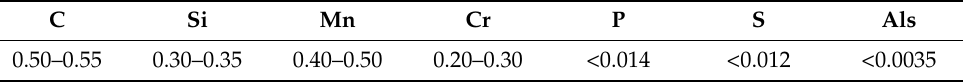
Table 1. Chemical composition of the experimental steel, wt%. C